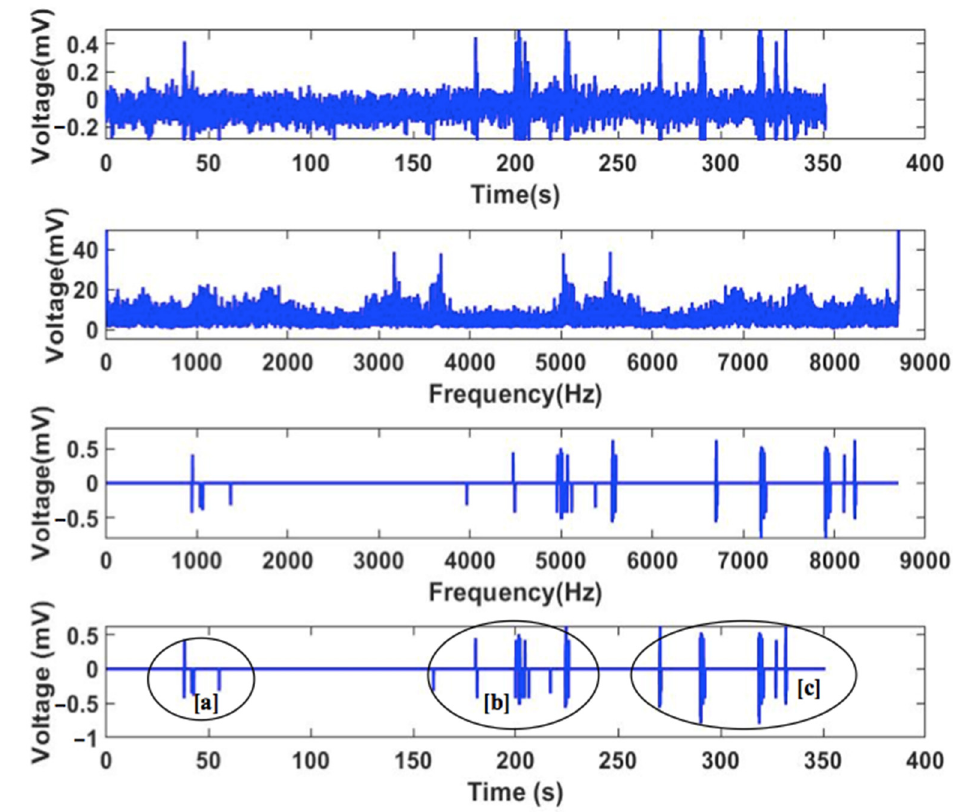
Figure 14. GFRP-SWCNT electromagnetic emitted voltage during mechanical loading and noise filter electromagnetic emitted voltage during mechanical loading where the slight charge release is labeled as [a]; upon further loading, crack propagates and more charge release was observed at both sections [b] and [c].